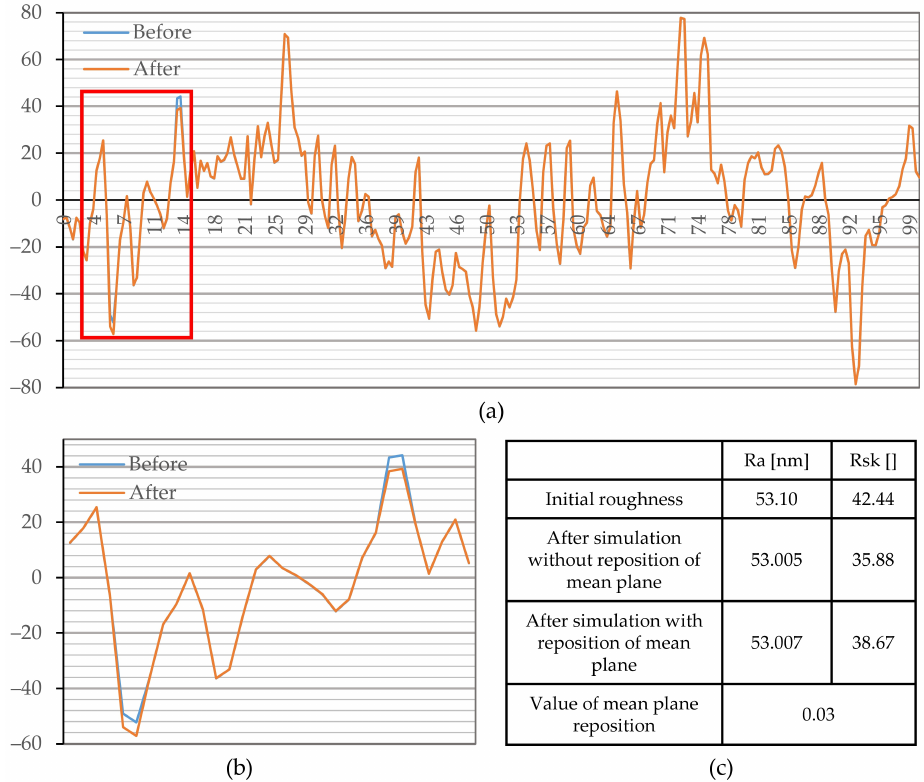
12. Simulation of localized and low-intensity corrosion attack (Simulation 2): ( a ) profile employed for analysis; ( b ) magnified marked location, on profile employed for analysis, that depict simulated effect of corrosion; ( c ) change in tracked parameters.